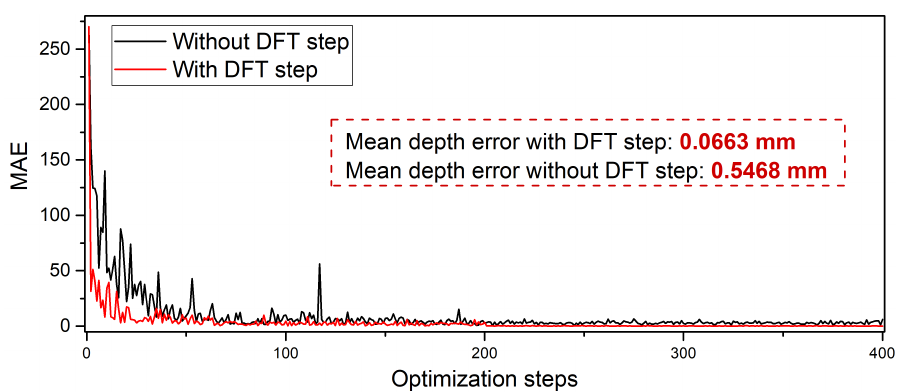
Figure A1. The influence of DFT step for locating accuracy and the speed of model convergence.